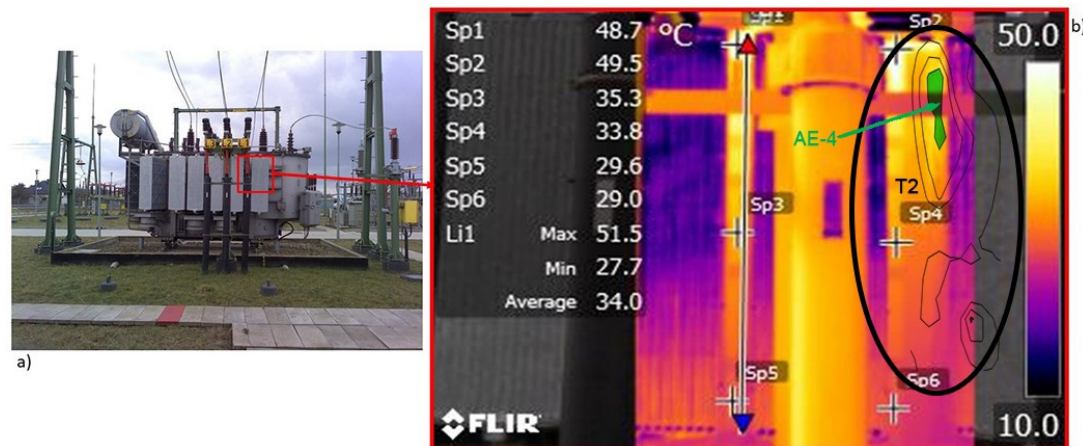
Figure 11. Thermograms of the IR radiation from the transformer’s surface recorded at the side of the low voltage bushings with quantitative information on the temperatures at the selected measurement points. General view of the transformer ( a ). T2 “hot spot”—the surface area with higher IR emissions delimited by a black envelope ( b ). The part of the AE-4 area with increased activity with descriptor value in the range of [-600, -300] is highlighted in green. The AE-4 area is inside the T2 area.